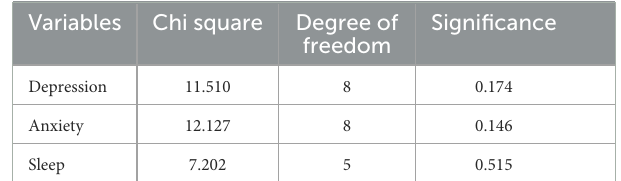
TABLE 5 Model goodness of fit